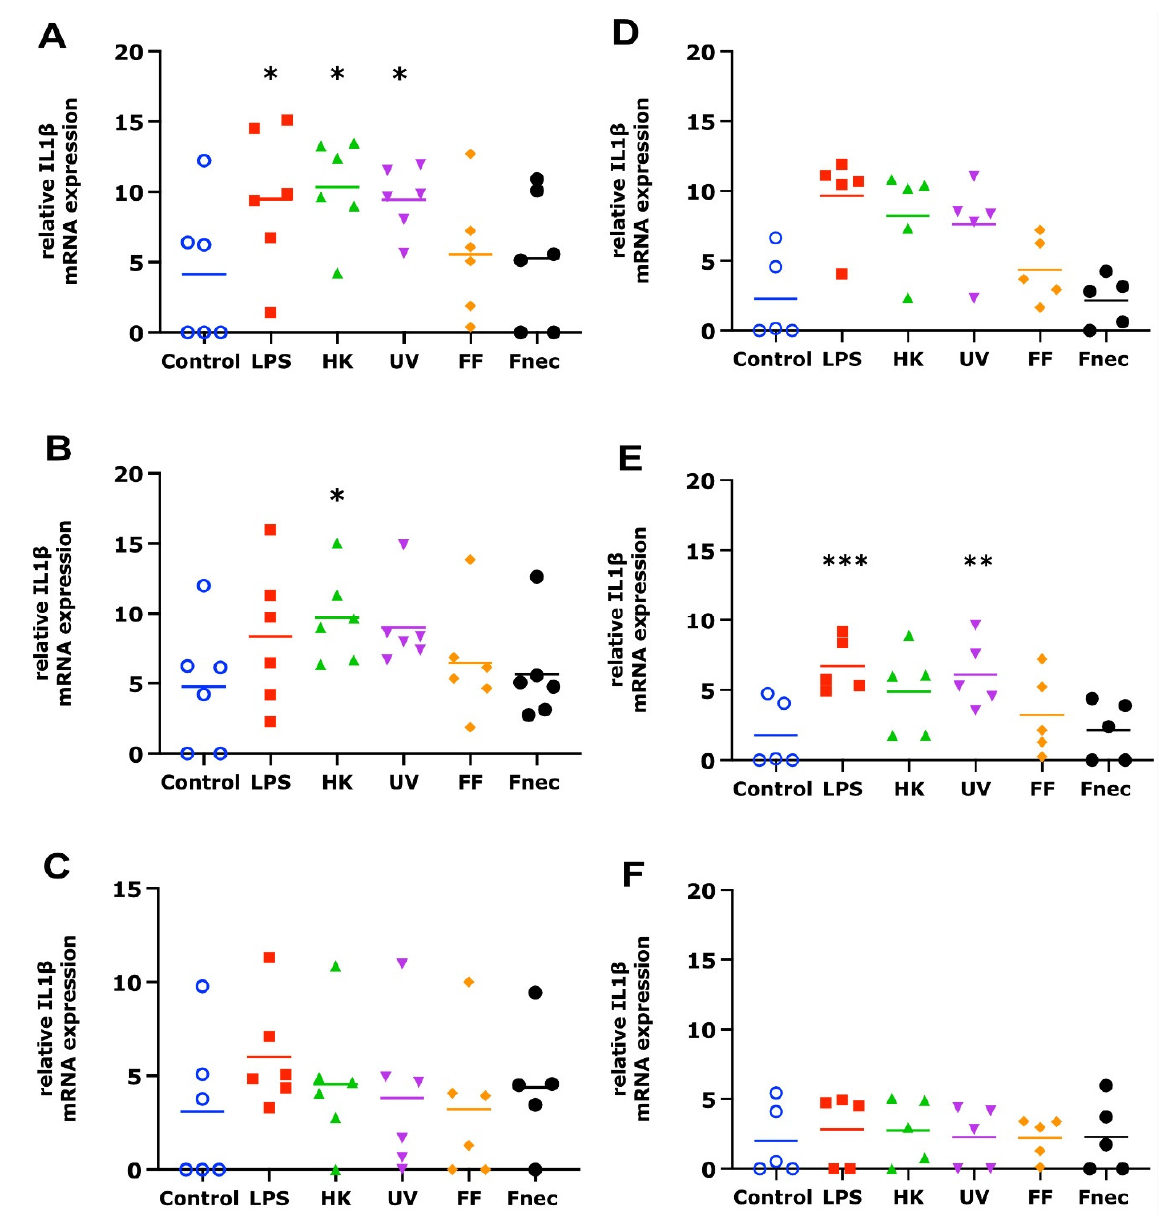
Figure 4. IL-1 β mRNA expression in interdigital ovine fibroblasts. Primary fibroblasts free of M. fermentans ( n = 6, ( A – C )) or naturally infected with M. fermentans ( n = 5, ( D – F )) were stimulated with 1 µ g/mL E. coli LPS, heat-inactivated D. nodosus (HK), UV-inactivated D. nodosus (UV), formalin-fixed D. nodosus (FF) or heat-inactivated F. necrophorum (Fnec) (cell culture medium was used as diluent and control) for 2 h ( A , D ), 8 h ( B , E ) and 24 h ( C ,F). Horizontal line indicates the mean. Each replicated symbol represents a different cell line from an individual sheep. One-way-ANOVA, followed by Dunnett’s multiple comparisons test: * p < 0.05, ** p < 0.01, *** p ≤ 0.001. In summary, the keratinocytes and fibroblasts naturally infected with M. fermentans showed little to no response to LPS, a range of D. nodosus preparations or heat-inactivated F. necrophorum . While in the fibroblasts (infected and Mycoplasma spp. free), the CXCL8 mRNA expression was generally mirrored in the CXCL8 release; no IL-1 β release was detected despite increases in the IL-1 β mRNA. This potentially suggests the signal for intracellular pre-IL-1 β processing may be lacking when culturing primary cell types